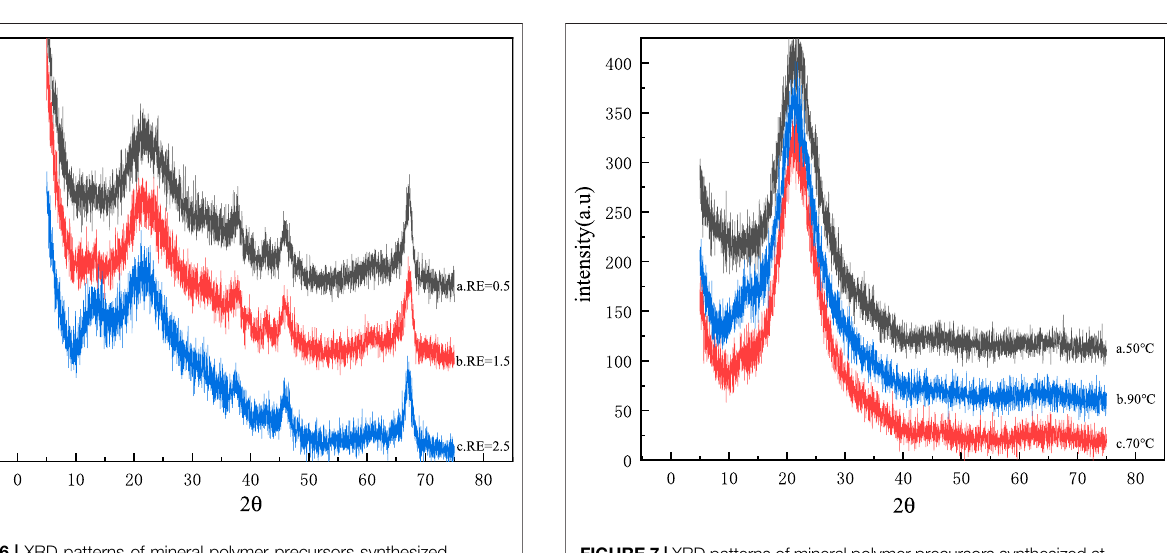
FIGURE 7 | XRD patterns of mineral polymer precursors synthesized at different synthesis temperatures.